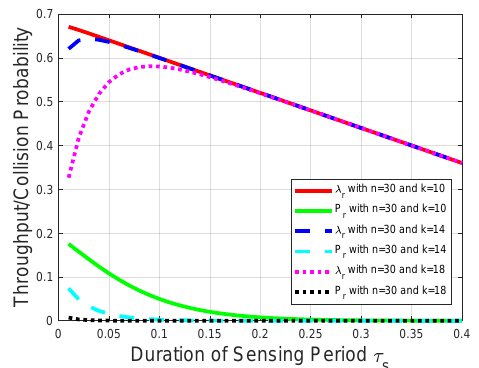
Figure 5. Throughput and collision performances of the CRN with a given reporting period and n in the “ k -out-of- n ” fusion rule.